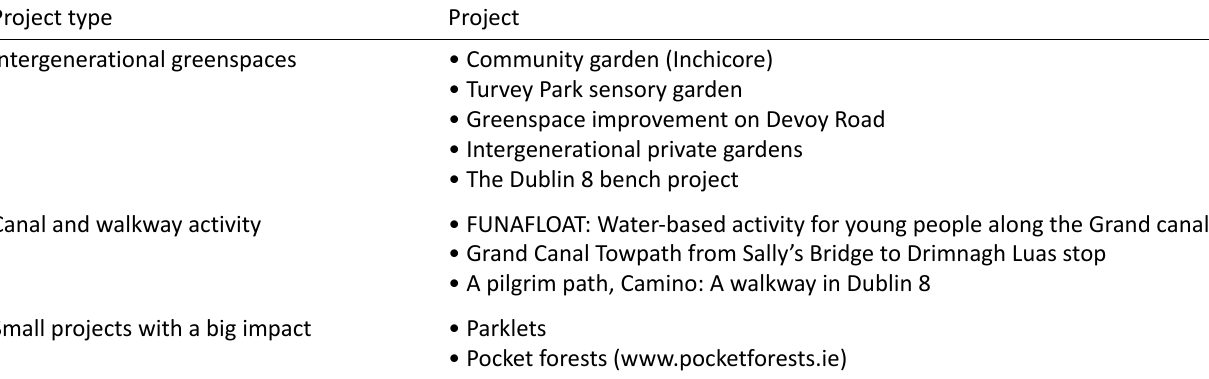
Table 4. Proposed projects developed by members of neighbourhood greening